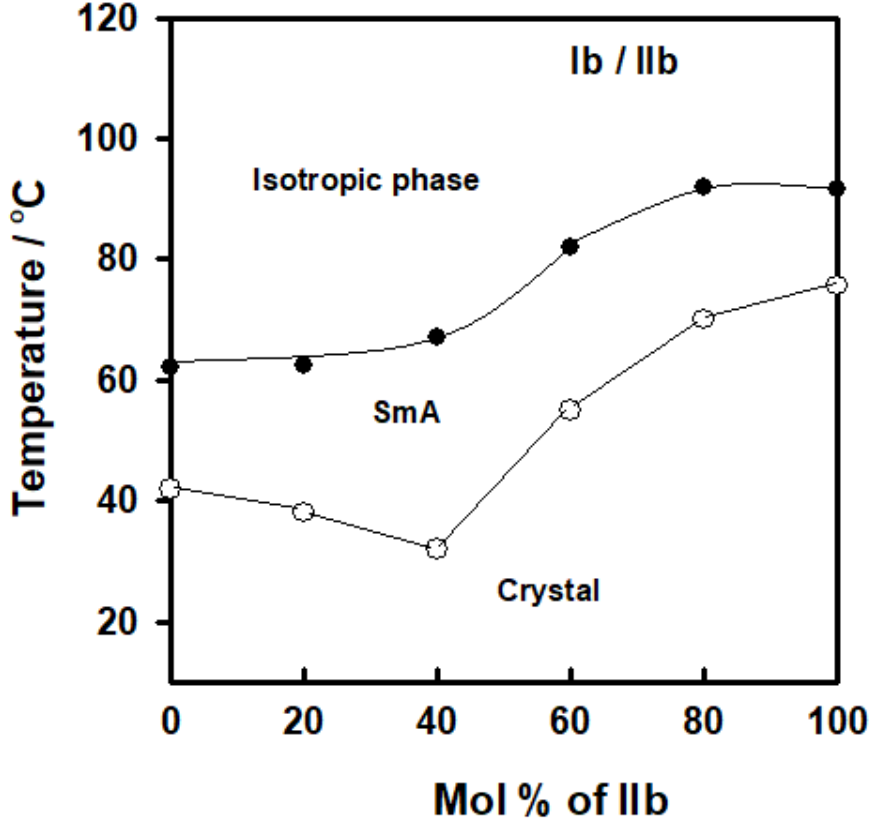
Figure 5. Binary phase diagram of Ib/IIb system.